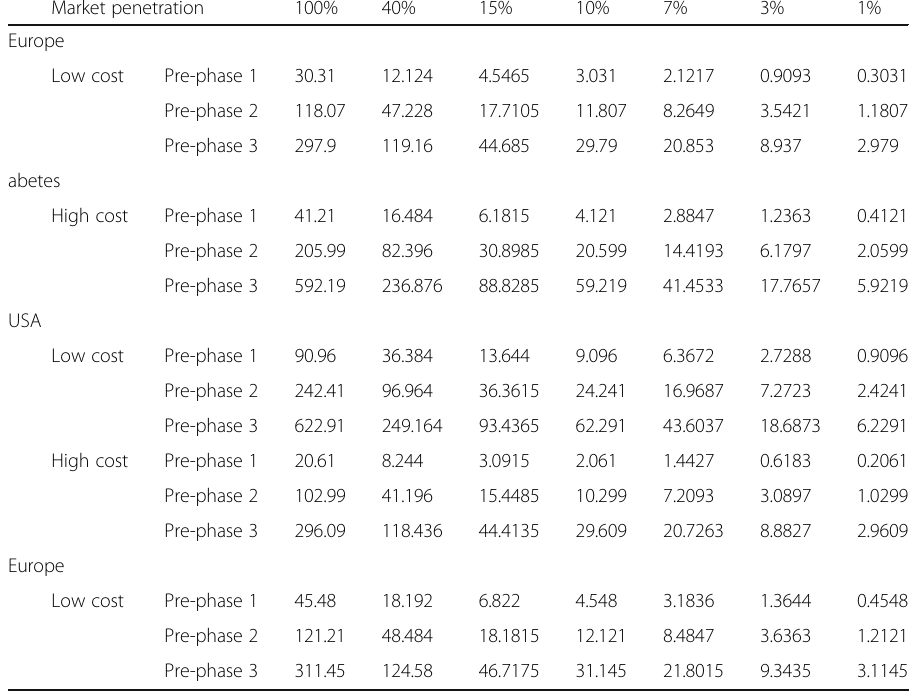
Table 6 SOM rNPVs for each market using real-world data potential market share (numbers in millions of USD)